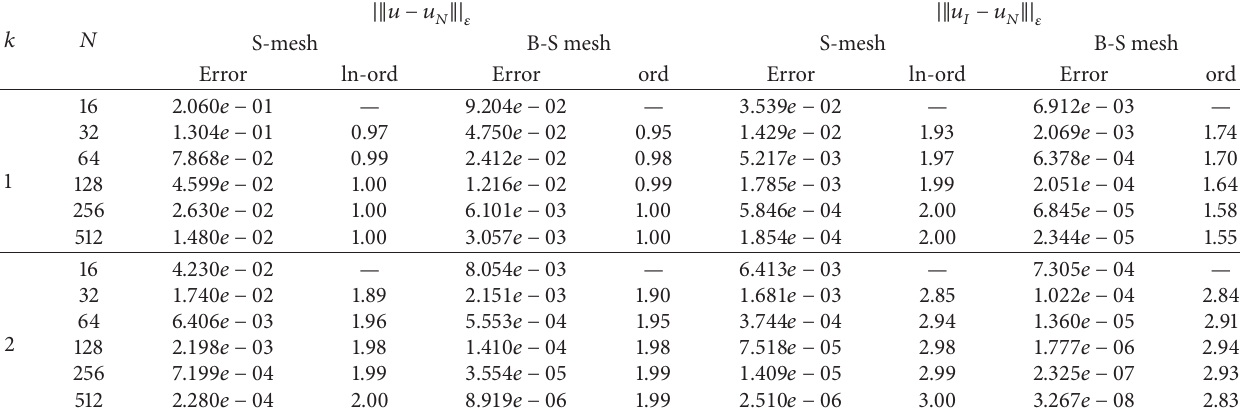
Table 2: History of convergence of the FEM/LDG coupled method, 𝜀 = 10 −6